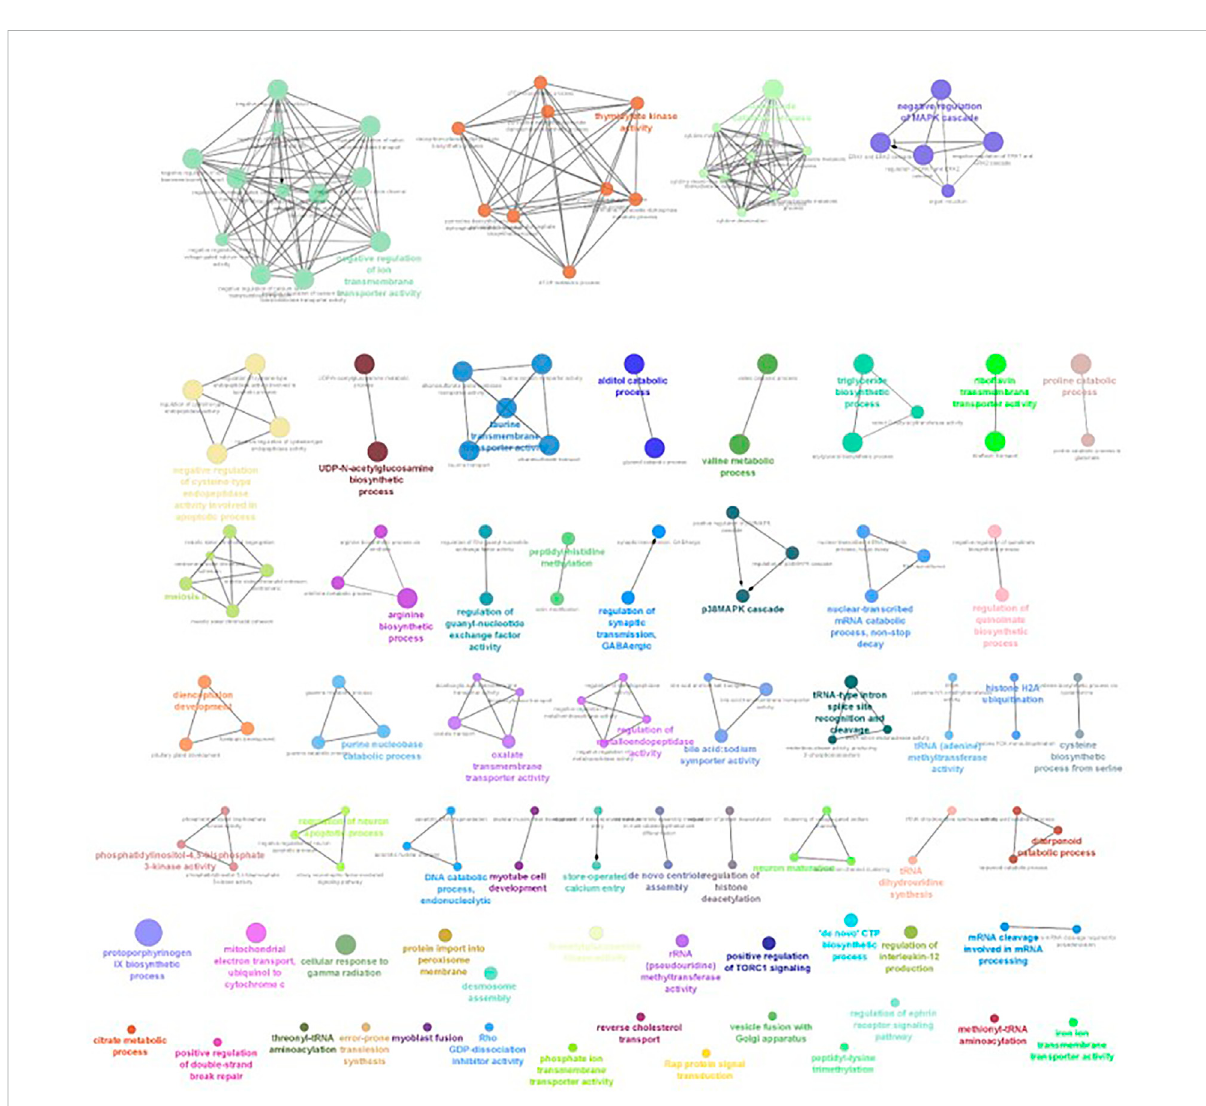
FIGURE 9 ClueGOenrichmentnetworkofthe8-pptsalinity-challengedtreatmentgroupDEGsof L.rohita ,withthe p -valuecutoff < 0.05,theinteractions of the GO terms network determined by functional nodes, and edges shared between differentially expressed genes with a kappa score of 0.4. The generated network has 238 nodes and 550 edges. Each node represents an individual biological process, and the color refers to the GO group. In total, 63 GO groups are present in the network, and edges represent the relationship between the GO terms based on the similarity of their associated genes. The bold font indicates an important GO term that de fi nes the name of the biological process of each